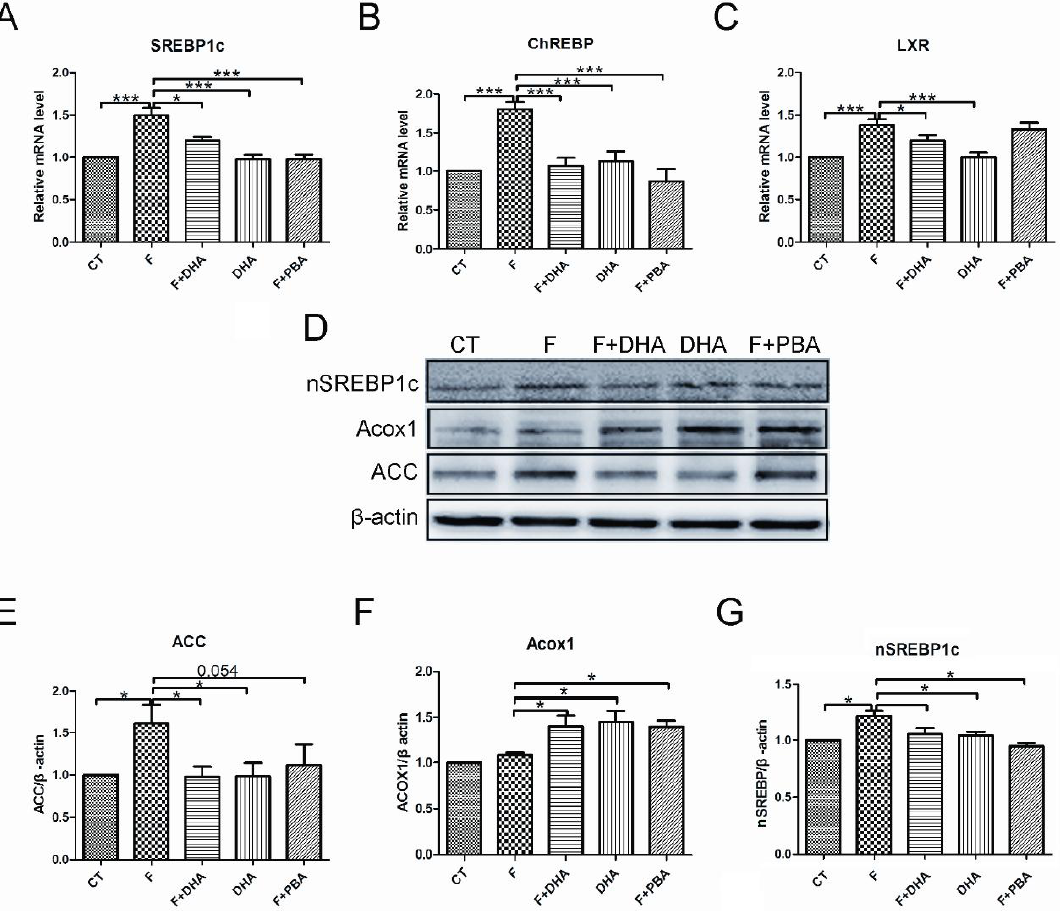
Figure 6. DHA selectively regulated gene expression related to lipid-homeostasis in primary mouse hepatocytes. CT: control; F: fructose; F + DHA: fructose plus DHA; F + PBA: fructose plus PBA pretreatment. Data are expressed as mean ± SEM ( n = 4). Data of five groups were compared by ANOVA with LSD’s test (* p < 0.05, *** p < 0.001).